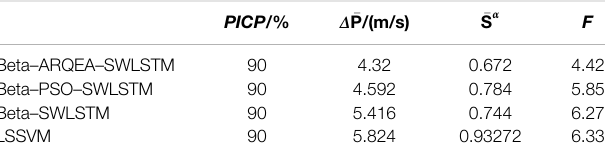
TABLE 3 | Performance of the compared PIWS